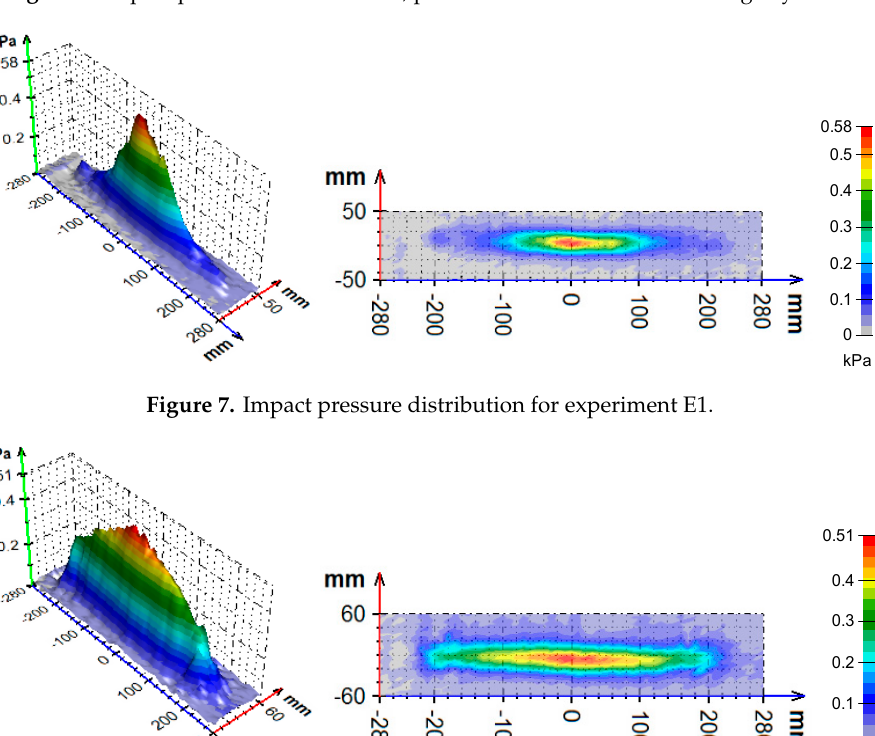
Figure 6. Impact pressure measurement, pin diameter of 10 mm on moving x–y table.